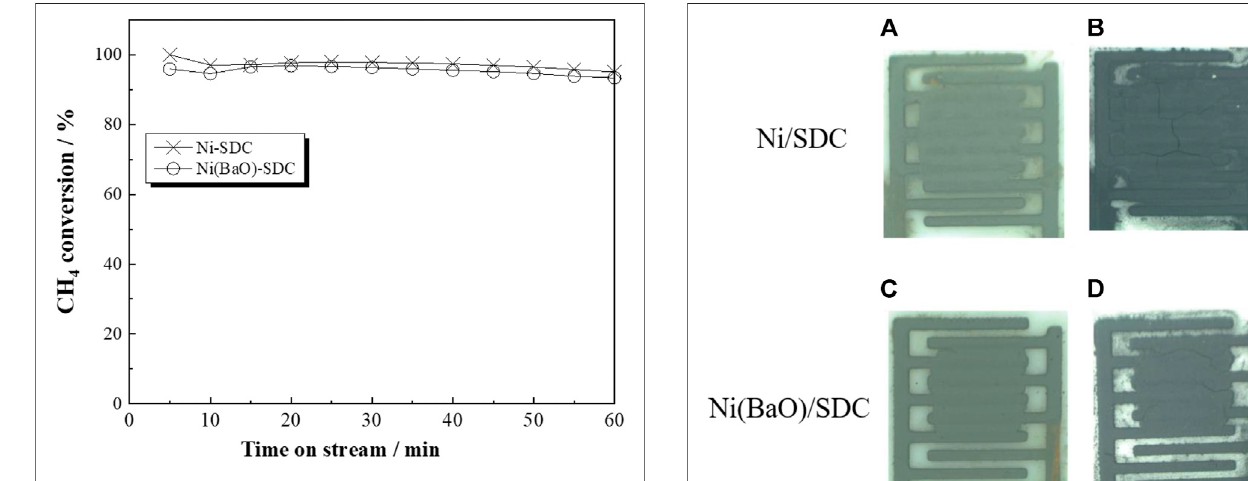
FIGURE5| TimeonthesteamofcatalyticCH 4 conversionoftheNi/SDC and Ni(BaO)/SDC powders measured under 1% CH 4 /He fl ow with GHSV (cid:1) 20,000 h − 1 at 700 °